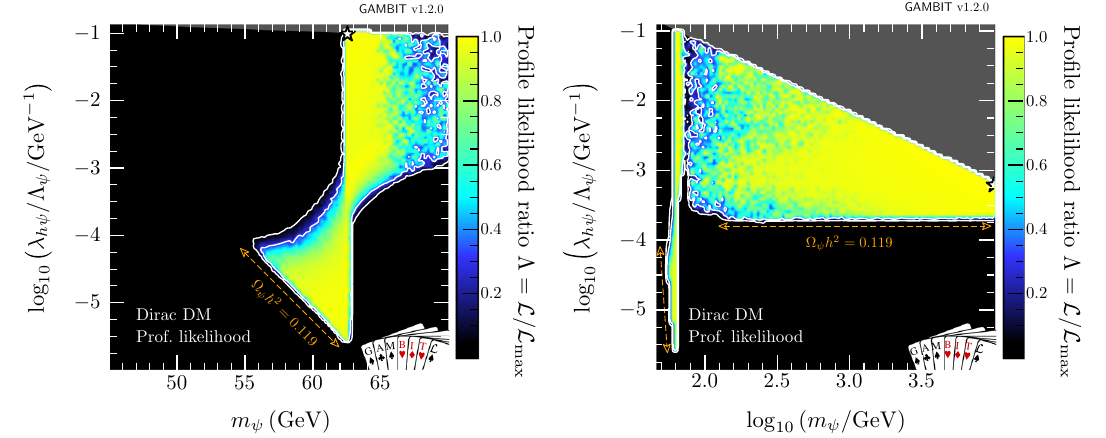
the EFT is violated, the white stars show the best-fit point for each mass region, and the edges of the preferred parameter space along which